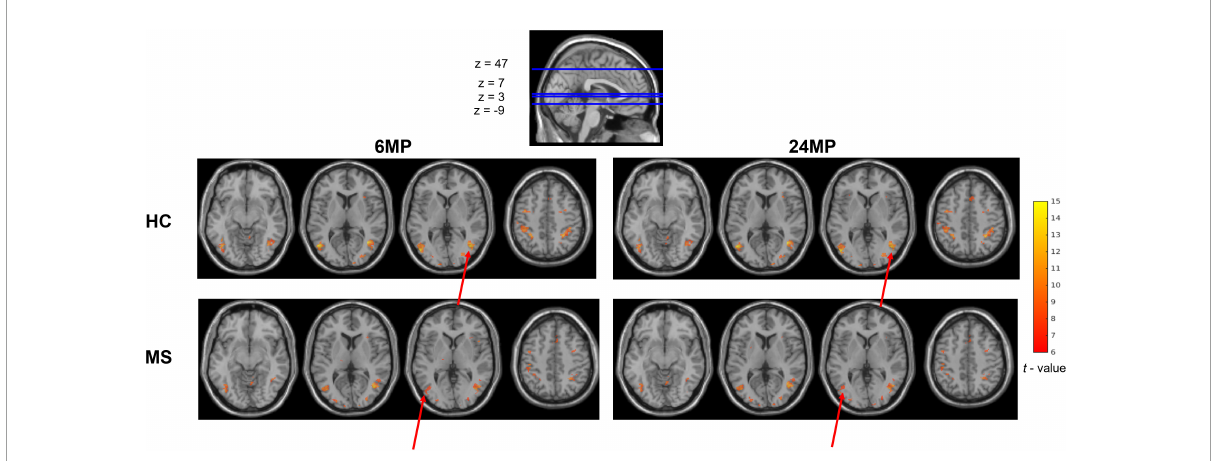
FIGURE4 Group mean activation maps, resulting from the contrast [motion–no motion] in all runs. On the left are represented activation maps resulting from models with 6 MPs. On the right are represented the activation maps resulting from models with 24 MPs. Results are thresholded at a voxel p -value < 0.05, FWE corrected for multiple comparisons. The color bar scale represents t -values. We can observe slightly higher extent of significant activations (red arrow) in the maps with 6 MPs which is consistent with the results of the statistical analysis (higher z -values for 6 MPs